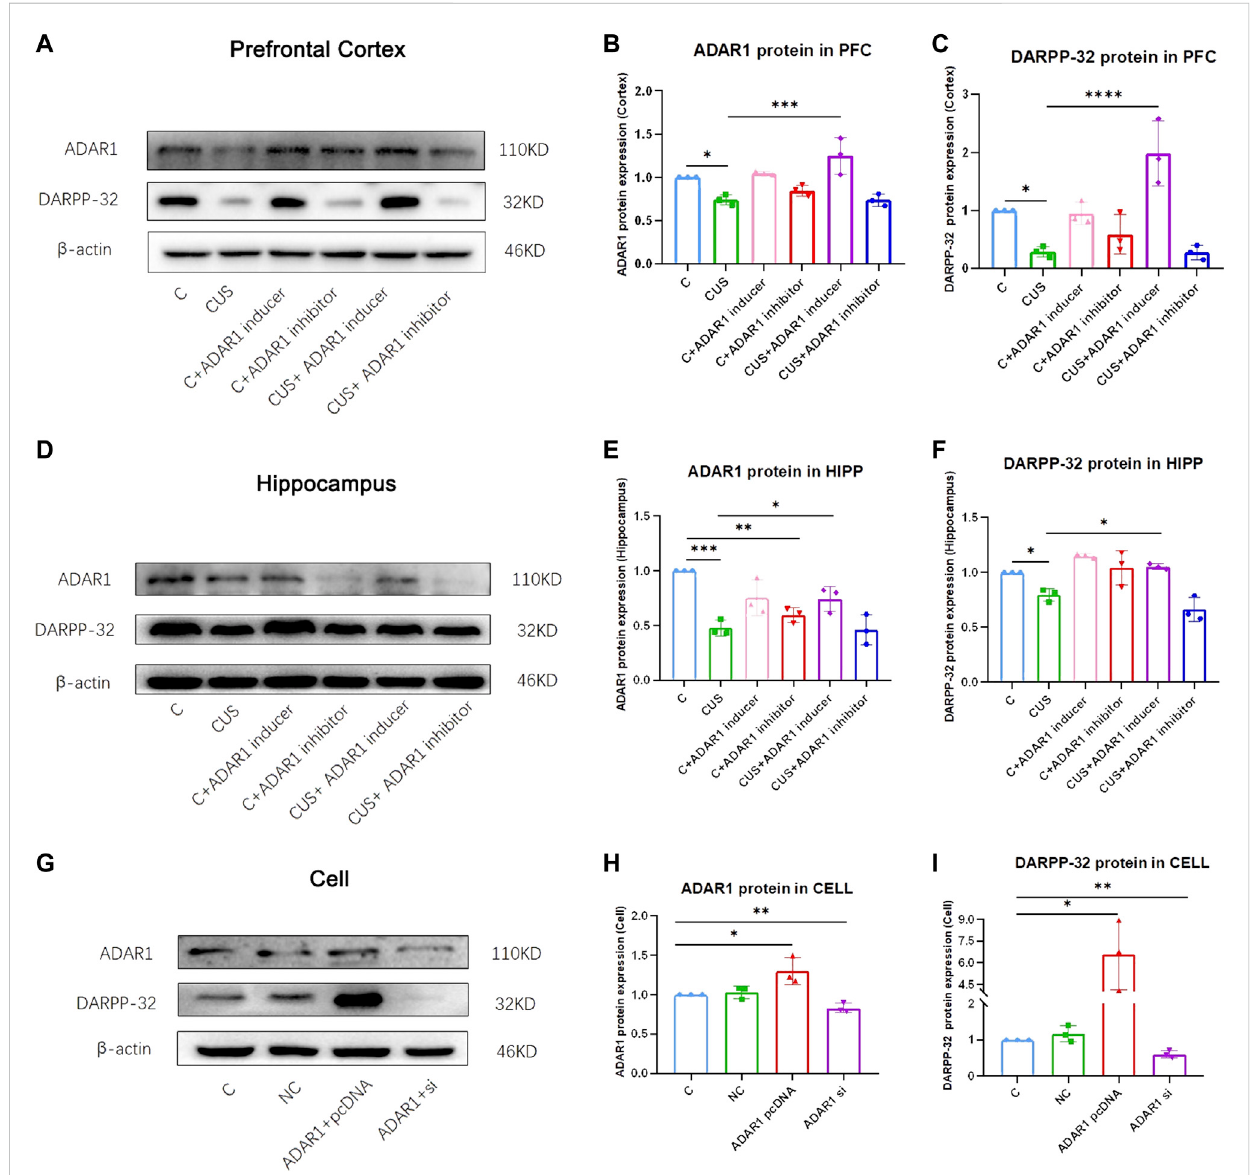
FIGURE 3 ADAR1 impacts DARPP32 protein expression in vivo and in vitro . (A) ADAR1 and DARPP-32 protein expression in prefrontal cortex of the mice. (B) Gray value analysis of ADARl protein expression in the prefrontal cortex of the mice. (C) Gray value analysis of DARPP-32 protein expression in the prefrontal cortex of the mice. (D) ADAR1 and DARPP-32 protein expressions in the hippocampus of the mice. (E) Gray value analysis of ADARl protein expression in the hippocampus of the mice. (F) Gray value analysis of DARPP-32 protein expression in hippocampus of the mice. “ C ” represents normalcontrolgroup, “ CUS ” representschronicunpredictablestressorstreatedmodelgroup, “ C+ADAR1inhibitor ” representstheADARlinhibitor(PEN/ EHNA) intervention control group; EHNA was used in the results of (A-I) , “ C + ADARl inducer ” indicates the ADARl inducer (IFN- γ ) intervention control group, “ CUS + ADAR1 inducer ” represents the ADARl inducer intervention model group, and “ CUS + ADAR1 inhibitor ” indicates the ADARl inhibitor intervention model group. (G) ADARl and DARPP-32 protein expressions in ADARl over/low-expression PC12 cell lines. (H) Gray value analysis of ADARl protein expression in ADARl over/low-expression PC12 cell lines. (I) Gray value analysis of DARPP-32 protein expression in ADARl over/low-expression PC12 cell lines. “ C ” represents the normal control group, “ NC ” represents the negative empty vector group, “ ADARl pcDNA ” represents the ADARl over- expression group, and “ ADARl si ” represents the ADARl low-expression group. * p < 0.05, ** p < 0.01, *** p < 0.001, **** p < 0.0001, ( n = 3/group). Data are expressed as mean ± standard